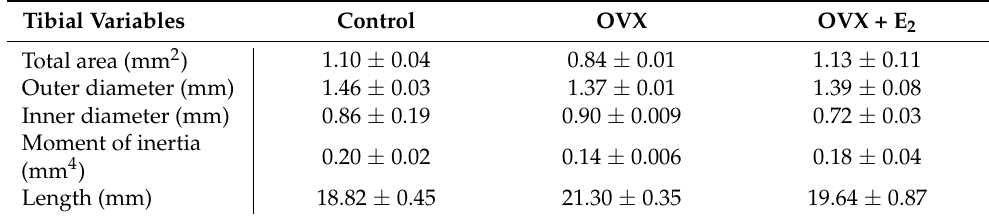
Table 5. The structural morphometric parameters of the control, OVX, and OVX + E 2 tibiae. Data are presented as mean ± standard error ( n =